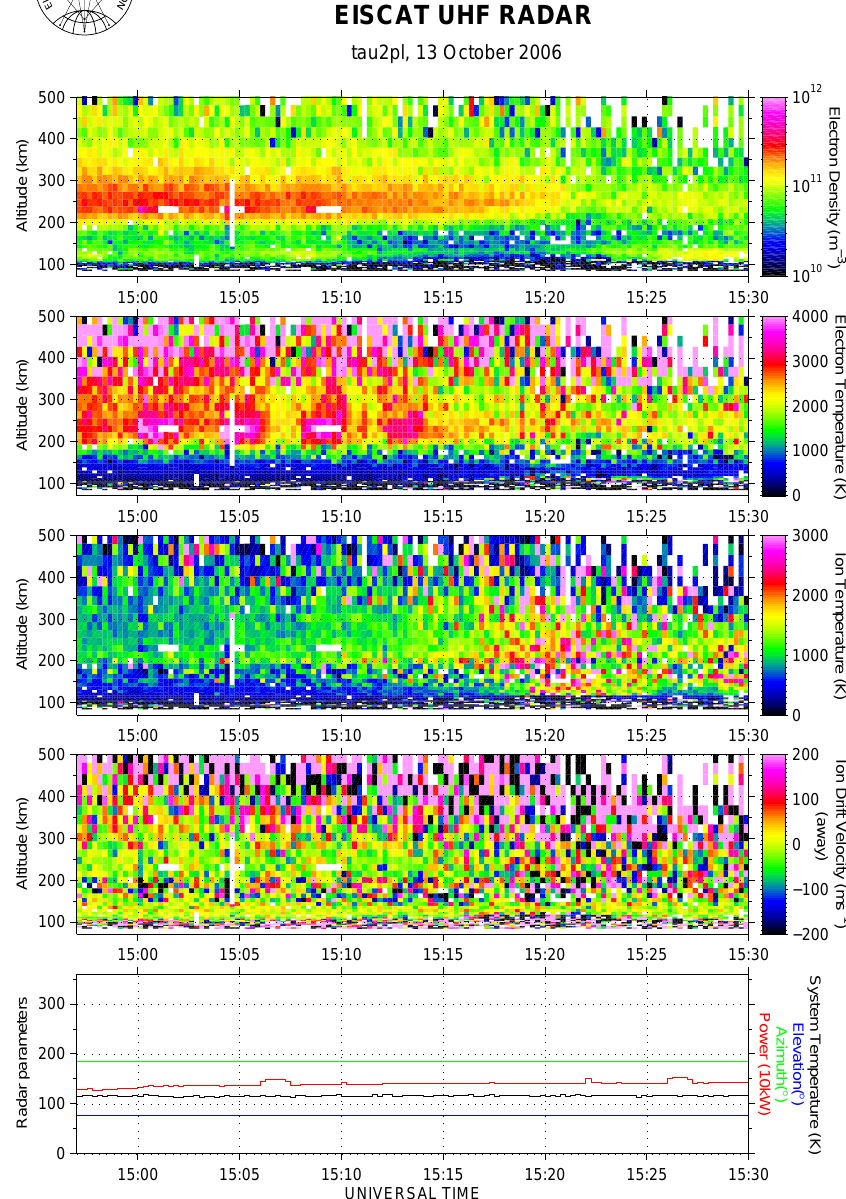
Fig. 6 Fig. 6. Data from the EISCAT UHF radar at Tromsø, showing the effects of HF pumping on 13 October 2006 from 14:58 to 15:30UT. The UHF radar beam pointed towards magnetic zenith, collecting long-pulse mode data analyzed with 15s integration time. The EIS- CAT/HEATING facility was operated from 15:00 to 19:00UT with a 2min on, 2min off pump cycle. White horizontal lines at the single range gate about 230km near the reflection height of the HF pump wave (the range gate most likely also including the upper hybrid resonance altitude) in the N e , T e , T i , and V i panels, and closely related to the first three heater-on periods, show data with a high residual to the fitting. This high residual error-bar is typical of echoes with strong Langmuir